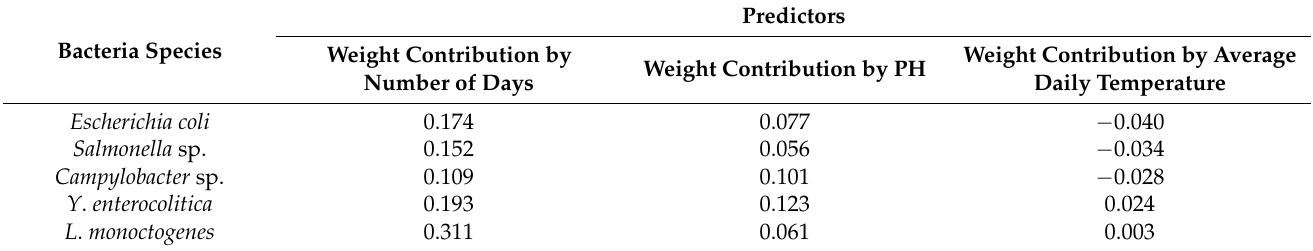
Table 2. Weight contribution of the